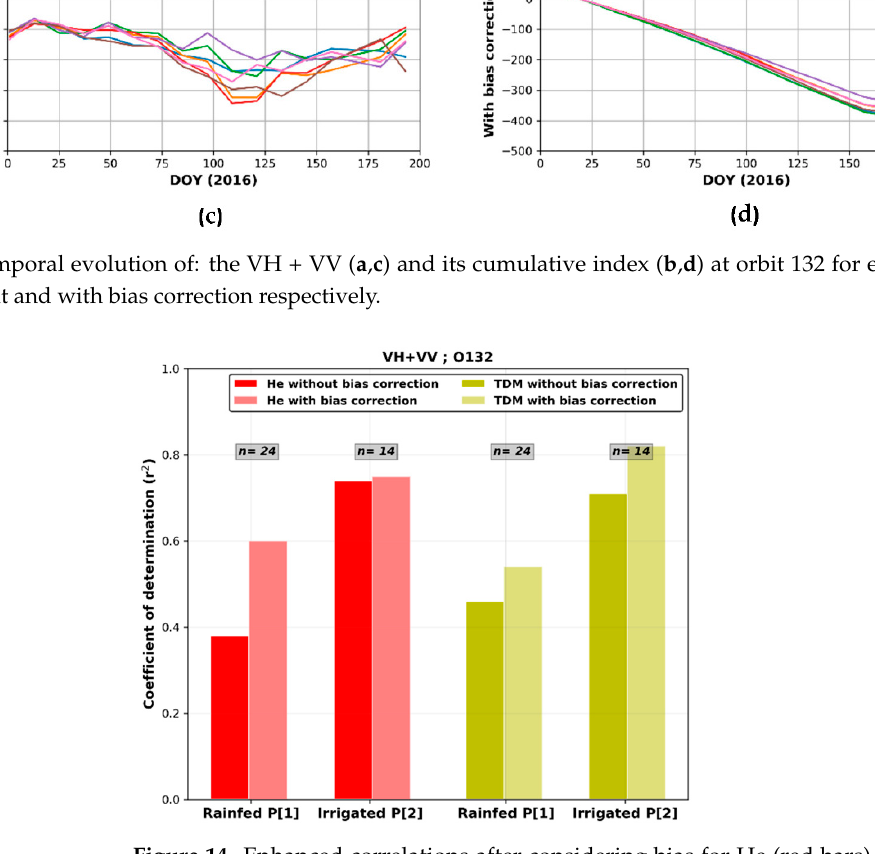
Figure 14. Enhanced correlations after considering bias for He (red bars) and TDM (yellow bars) parameters. Table 5. Comparison between the statistical coefficients R 2 determined between all crop parameters and VH + VV and VH − VV for the two orbits O30 and O132